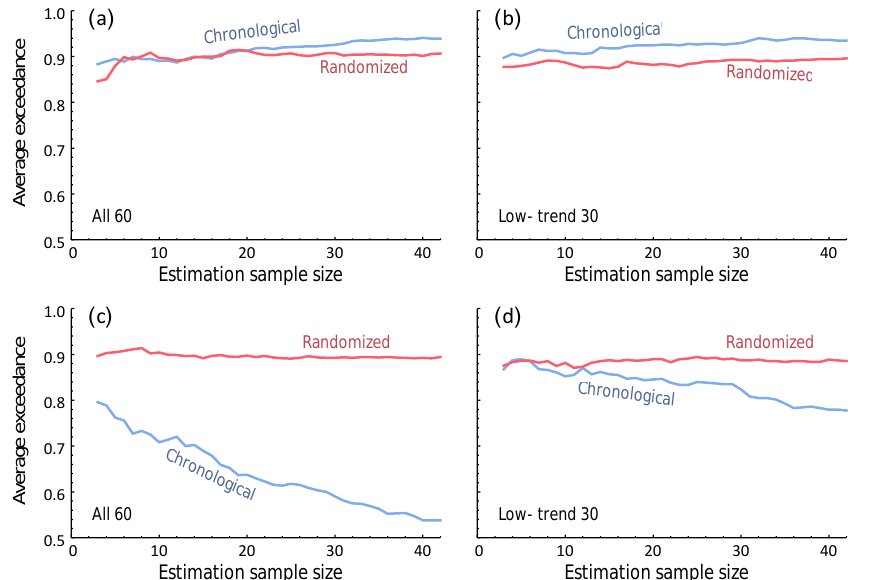
Figure 11. P90 “thought experiment”. (a) , (b) Average exceedance of P90 estimator, using the actual mean of the final 20 years, for all 60 stations, and for the subset of 30 stations with global near-zero trend, respectively. (c) , (d) Average exceedance using the actual standard deviation of the final 20 years, for the 60 and 30 station sets, respectively. Traces are, but for a slight adjustment for weighting, 1 / 1200th (1 / 600th for the 30 stations subset) of the count, totaled across all 60 (30) stations, of final-segment years with capacity factor exceeding each station’s P90 estimate. Blue: actual data; red: randomly permuted